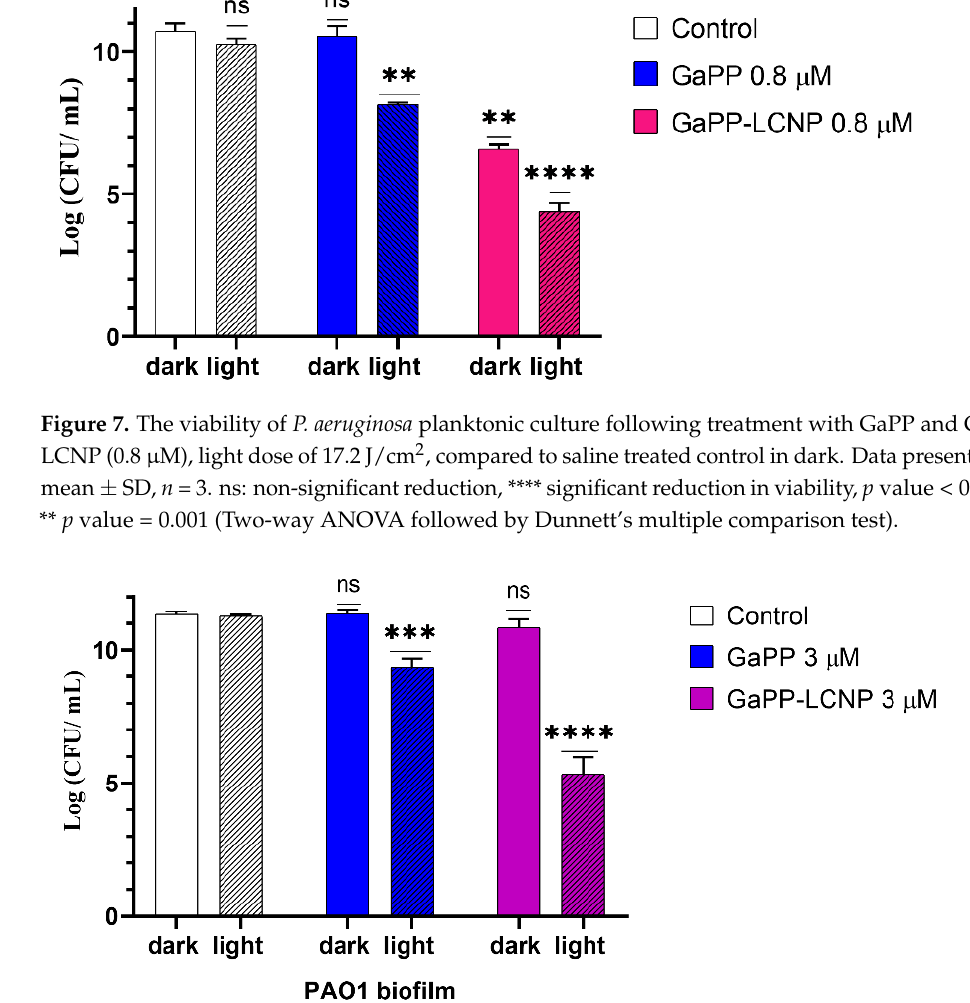
Figure 8. The viability of P. aeruginosa biofilm following treatment with GaPP and GaPP-LCNP (3 µ M), light dose of 34.2 J/cm 2 , compared to saline treated control in dark. Data presented as mean ± SD, n = 3. ns: non-significant reduction, *** significant reduction p value = 0.0007, **** p = <0.0001, (Two-way ANOVA, followed by multiple comparison Dunnett’s test).